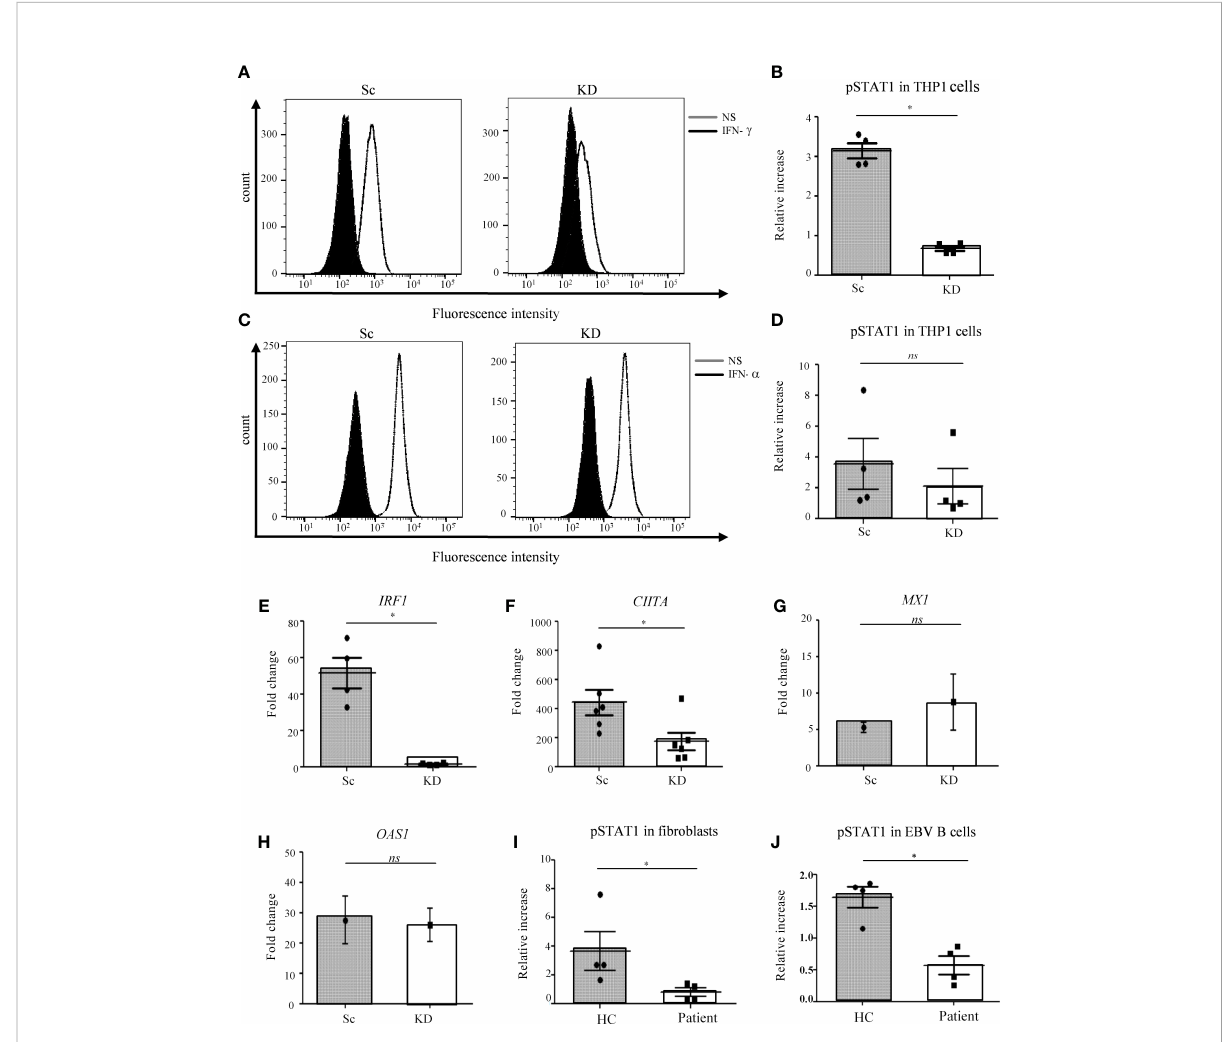
FIGURE 1 STAT1 responses are impaired in JAK1-de fi cient THP-1 cells, fi broblasts and EBV-B cells. (A – D) Analysis of JAK/STAT signaling by fl ow cytometry (FC) in THP-1 cells after IFN- g /IFN- a stimulation. (A) and (C) display a representative experiment, (B) and (D) are from four independent experiments. Two-tailed Mann Whitney test. (E, F) RTqPCR analysis of IRF1 and CIITA expression from THP-1 cells after IFN- g stimulation. Data is from fi ve independent experiments. Two-tailed Mann Whitney test. (G, H) RT-qPCR analysis of MX1 and OAS1 expression in THP-1 cells after stimulation with 1000 IU/ml IFN- a . Graphs represent the mean of three experiments. Data was compared using unpaired t-test. (I, J) Analysis of JAK/STAT signaling by FC in control and patient fi broblasts and EBV-B cells after stimulation with IFN - g . Data are from four